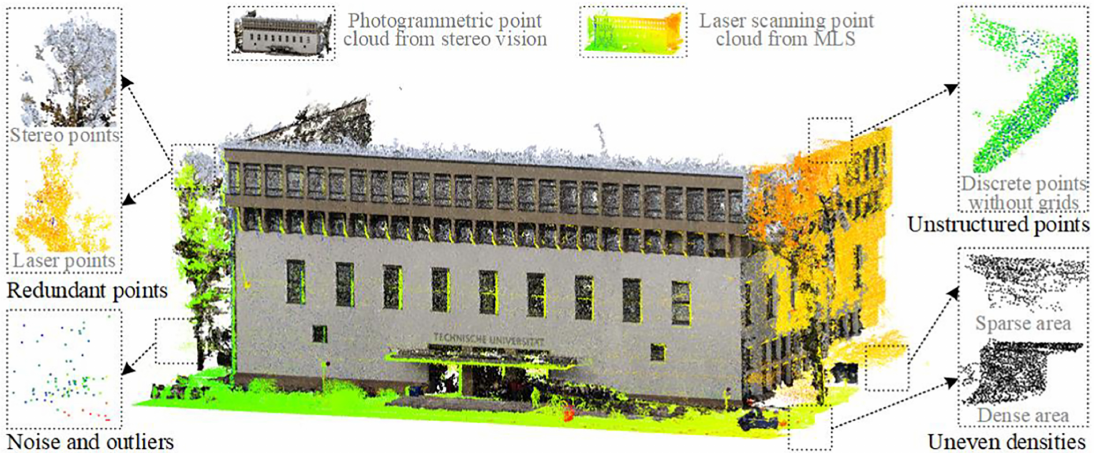
Figure 1. Challenges in raw point clouds acquired from laser scanning and stereo vision (i.e., photogrammetry). (Source: Xu et al. (2021). [1]).